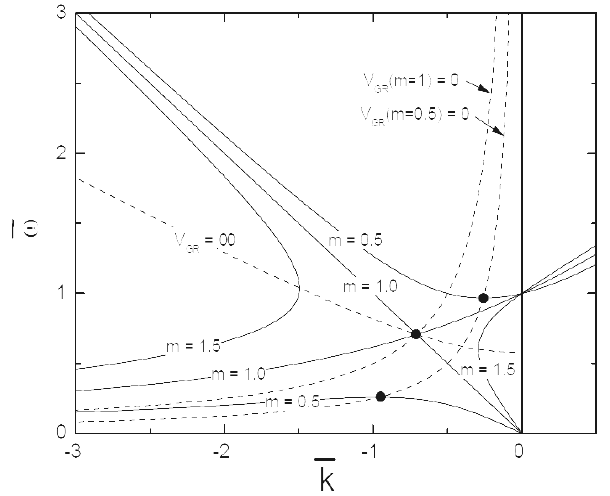
Fig. 2. The equatorial dispersion curves for n = 0 , 1 , 2. Note that the n = 0 curves, corresponding exactly to the m = 1 curves of the mid-latitude case, all intersect at the intersection between the locii of zero and infinite group velocity. This case is “marginally stable”.